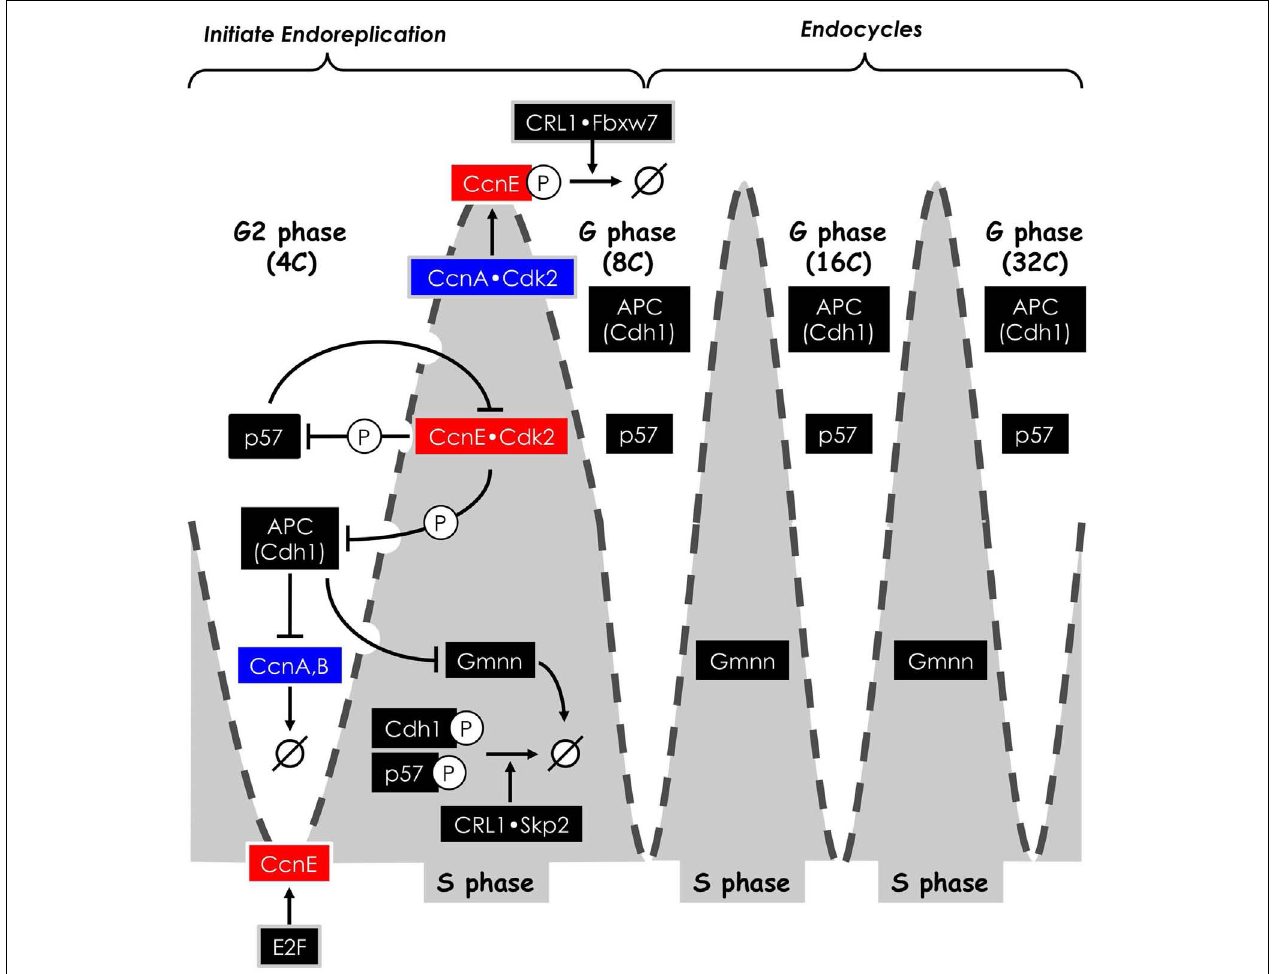
result from a sequence of feedback loops, resulting from phosphorylation events by Cdk2 • CcnE, and ubiquitination events by CRL1 and the APC. Ubiquitination by CRL1 requires prior CDK-dependent phosphorylation of its substrate.These events inhibit the activity of their protein targets and cause them to be degraded by the 26S proteasome ( → ∅ ). Protein names are those for